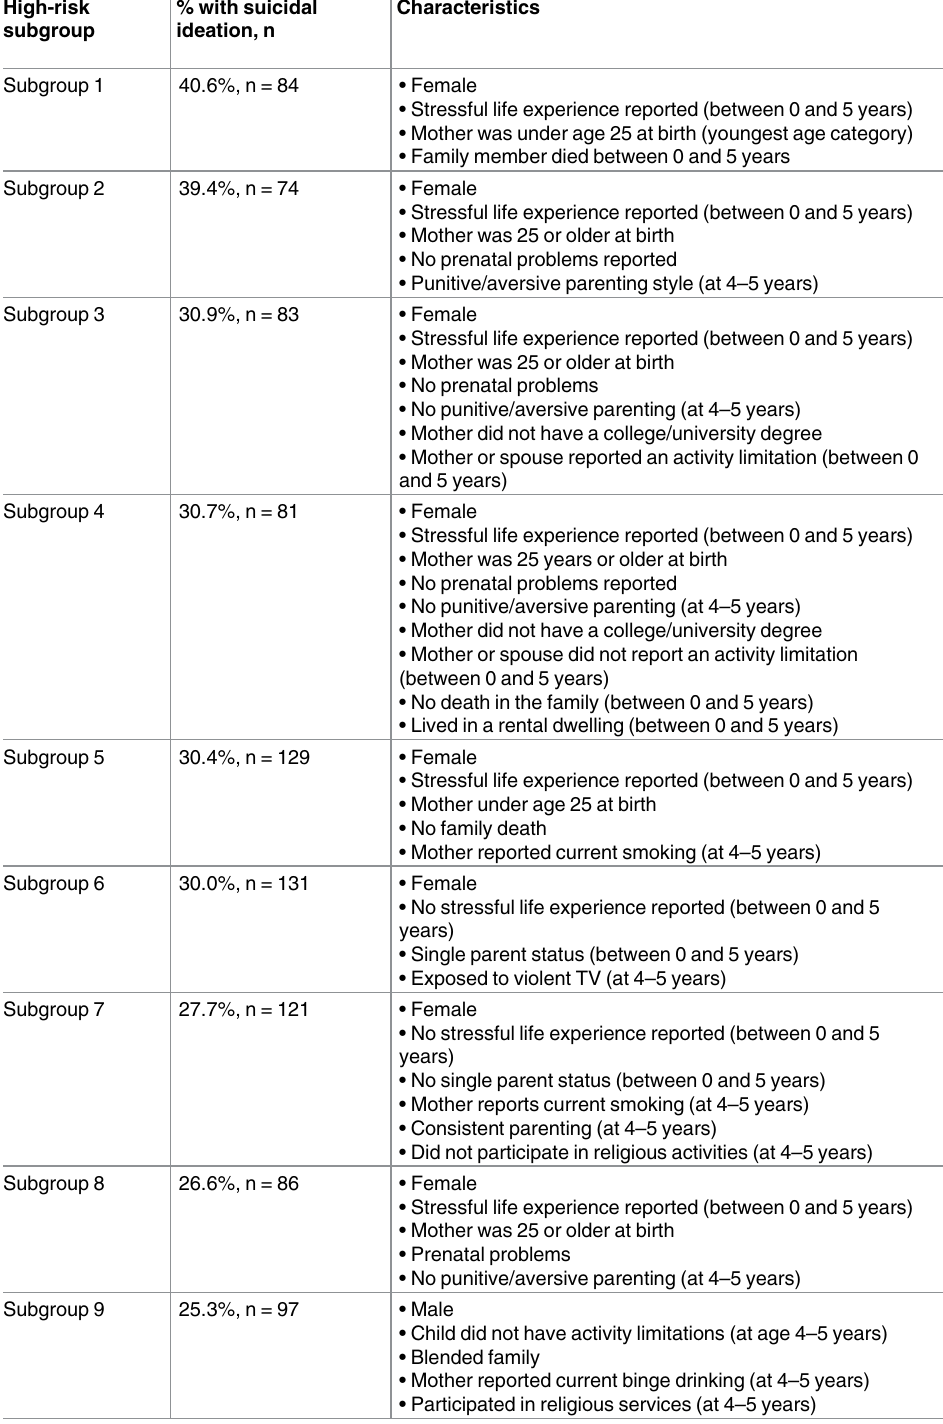
Table 2. Profiles of high-risk subgroups in Classification and Regression Tree model (CART), NLSCY, Canada,